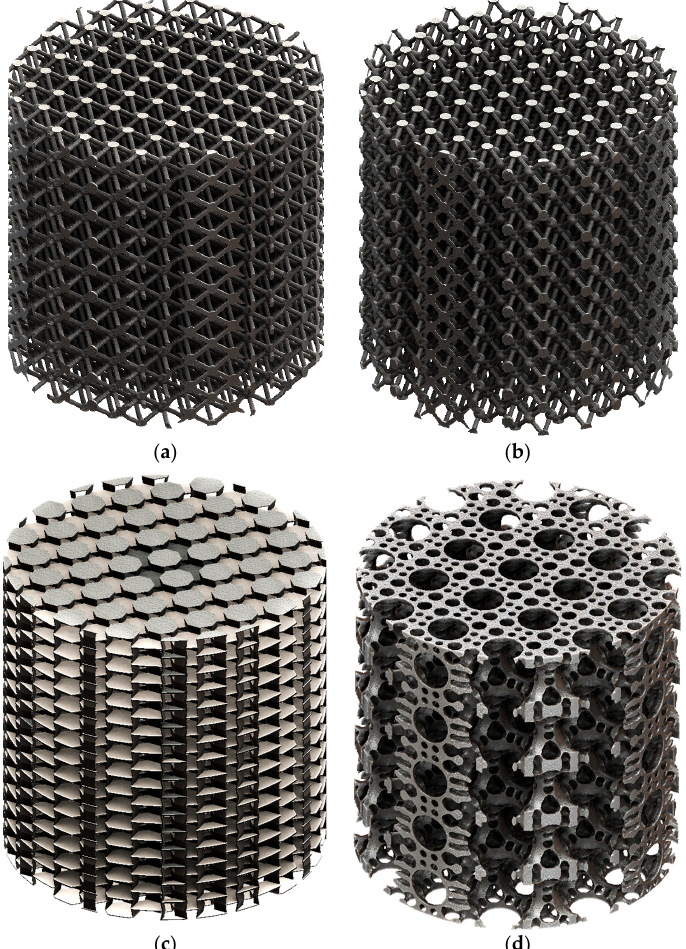
Figure 7 . Lattice CAD model rendered for the following topologies: ( a ) BCC; ( b ) FCC; ( c ) AUX; ( d ) ORG. Dimension ( D:50 mm, L:50mm) Table 5 . Summary of geometric properties of lattice models.